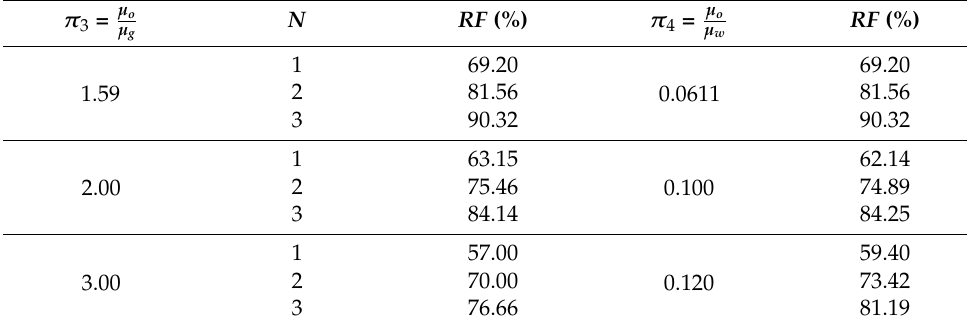
Table 10. π 3 and π 4 sensitivity analysis to assess the WAG flooding